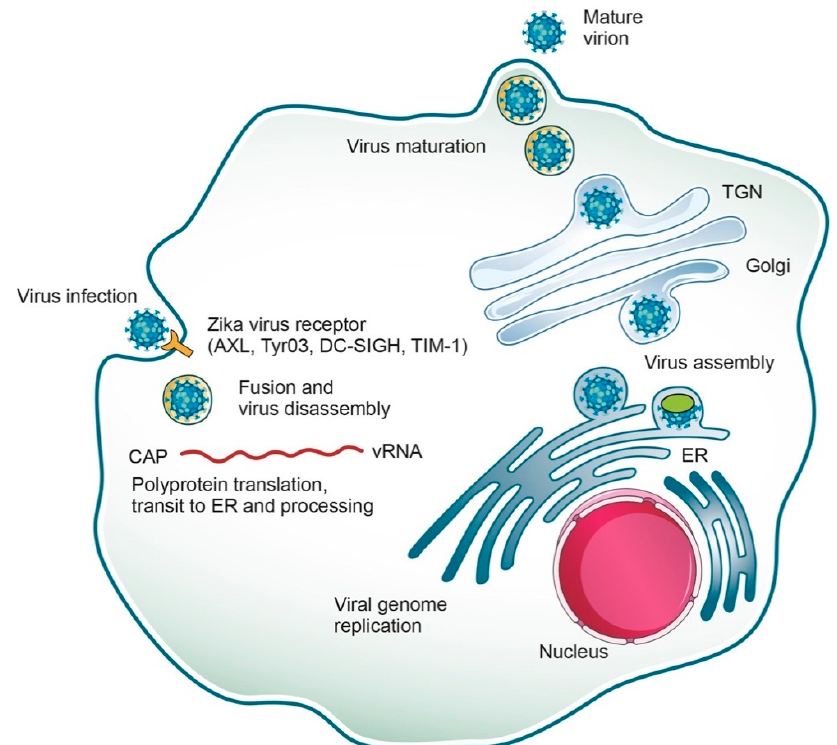
Figure 2. Zika virus life cycle. ZIKV, an enveloped RNA virus, enters cells by receptor-mediated endocytosis and fuses its membranes by an acidic-pH-triggered mechanism in the endosome (via cell surface receptors such as AXL, Tyro3, DC-SIGN and TIM-1) to release the viral RNA. The ssRNA is then translated, and the resulting polyprotein is further cleaved into various structural and non-structural proteins (C, prM, E and NS proteins). Replication takes place in the endoplasmic reticulum (ER) surface. Transcription and replication of the dsDNA results in the formation of new viral mRNA and ssRNA, respectively. Virus assembly takes place in the ER membrane and leads to the formation of immature virions, which are transported through the exocytic pathway. The prM protein is cleaved and the virus is rendered mature. Finally, the mature virus exits the cell via